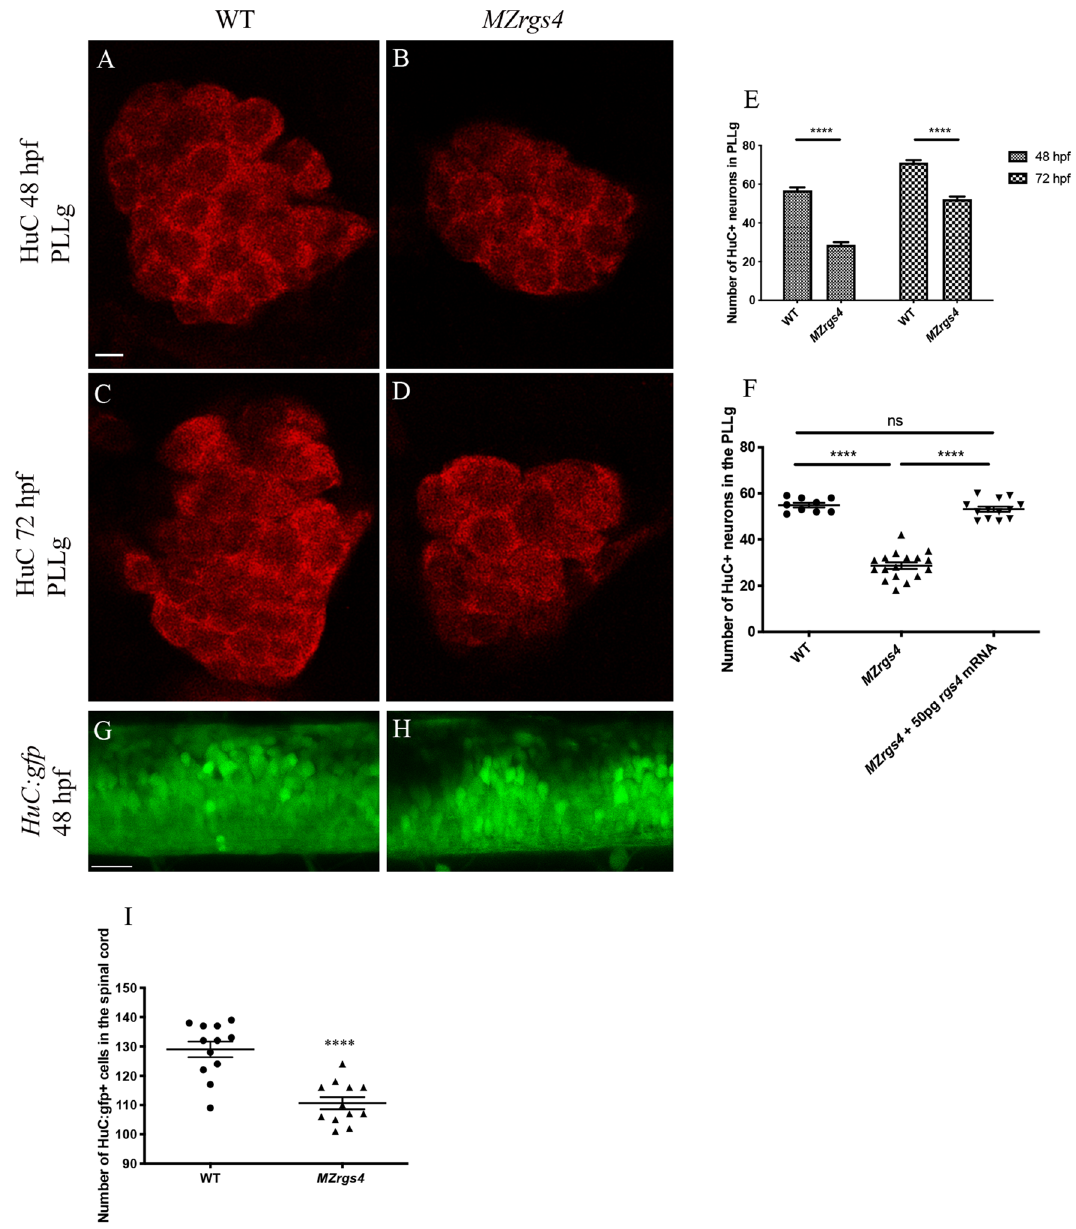
Figure 3. Rgs4 is required for neuronal development in the PLLg and spinal cord. ( A – D ), single planes of confocal microscopy images representing the PLLg following HuC labelling at 48 and 72 hpf in WT (A,C) and MZrgs4 (B,D). Scale bars = 5 μm. ( E ) Graph showing the number of neurons within the PLLg in WT (average of 56.70 ± 1.43, n = 10 at 48 hpf; average of 71.17 ± 1.25, n = 12 at 72 hpf) and MZrgs4 embryos (average of 29.14 ± 1.71, n = 14 at 48 hpf; average of 52.14 ± 1.33, n = 21 at 72 hpf) at 48 and 72 hpf. ( F ) Quantification of the number of neurons in the PLLg following rgs4 mRNA injection in MZrgs4 mutants at 48 hpf (average of 54.89 ± 1.01 neurons in WT, n = 9; average of 28.65 ± 1.43 neurons in MZrgs4, n = 17; average of 53.15 ± 1.13 neurons in MZrgs4 + rgs4mRNA , n = 13). ( G , H ) single planes of confocal microscopy images of Tg(HuC:gfp) (G) and Tg(HuC:gfp)/MZrgs4 (H) at 48 hpf. Scale bar = 20 μm. ( I ) Quantification of the number of HuC:gfp + cells within the same area of the spinal cord in WT (average of 129 ± 2.70 gfp + cells, n = 12) and MZrgs4 (average of 110.7 ± 2.07 gfp + cells, n = 12) at 48